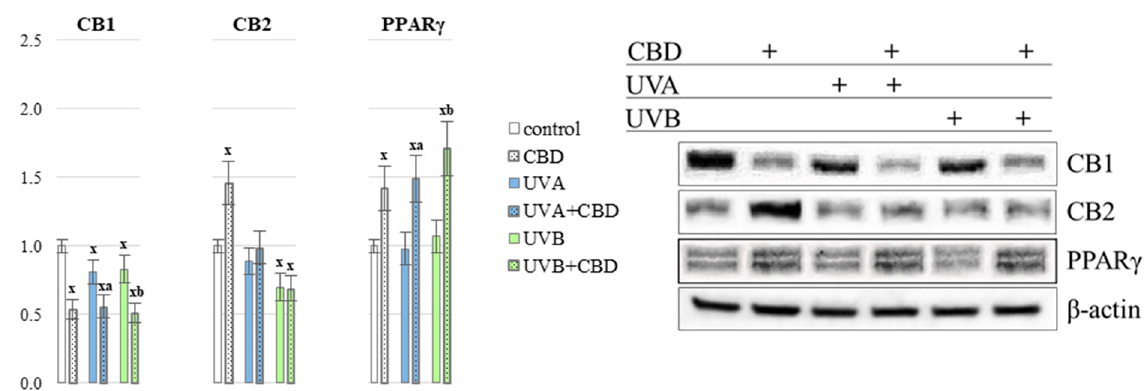
Figure 10. Endocannabinoids receptors expression CB1, CB2 and PPAR γ in the PMNs of nude rats in the following groups: control; treated with CBD (every 12 h) for 4 weeks; irradiated with UVA (every 48 h) for 4 weeks; irradiated with UVA (every 48 h) and treated with CBD (every 12 h) for 4 weeks; irradiated with UVB (every 48 h) for 4 weeks; irradiated with UVB (every 48 h) and treated with CBD (every 12 h) for 4 weeks. The mean values for six rats in each group ± SD are shown: x—differences vs. control group, p < 0.05; a—differences vs. UVA treated group, p < 0.05; b—differences vs. UVB treated group, p < 0.05.